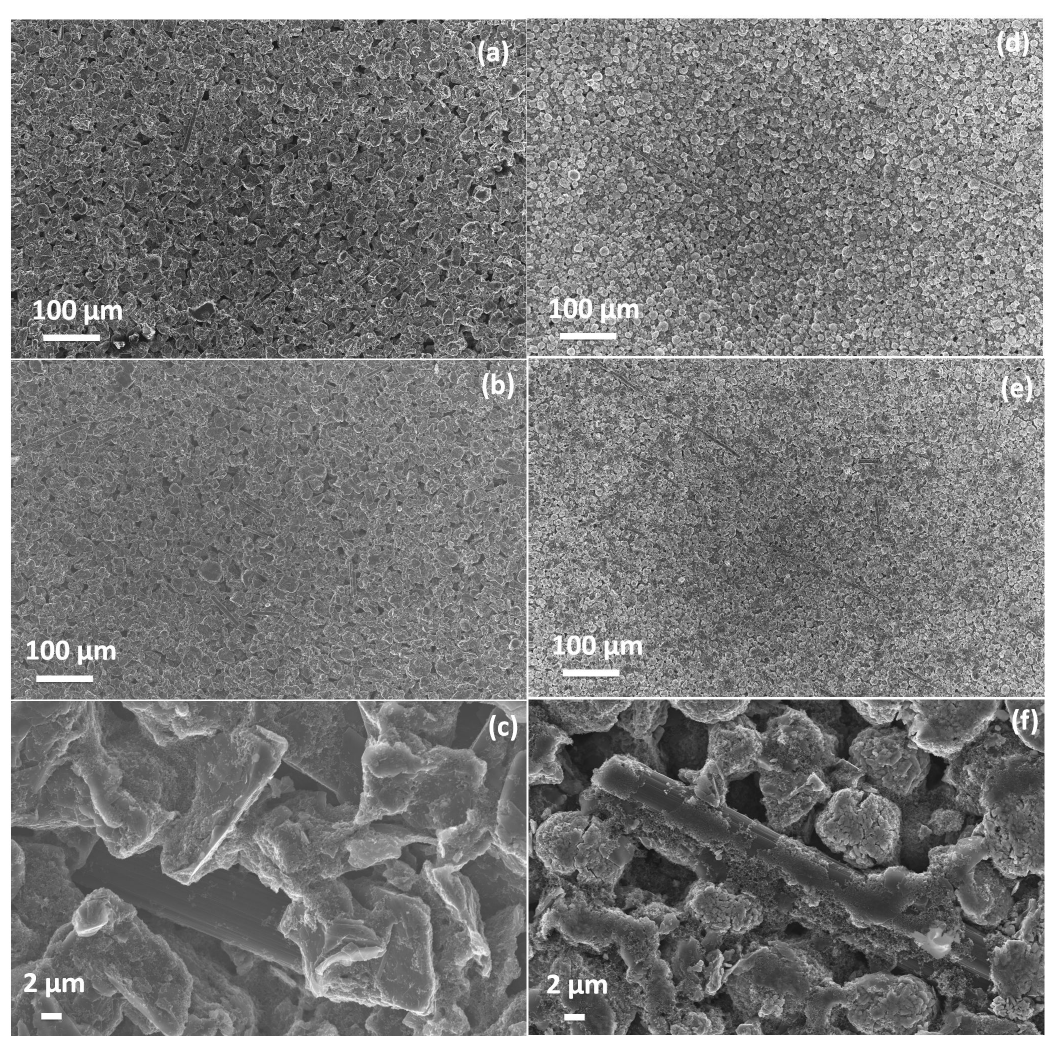
Figure 1. Scanning electron microscope (SEM) images of the thick electrodes. ( left ) Graphite anode: ( a ) as-coated (350 µ m, porosity 58%); ( b ) calendered (280 µ m, porosity 48%); and ( c ) high magnification (280 µ m, porosity 48%). ( right ) Lithium nickel manganese cobalt oxide (NMC) cathode: ( d ) as-coated (300 µ m, porosity 44%); ( e ) calendered (250 µ m, porosity 38%); and ( f ) high magnification (250 µ m, porosity